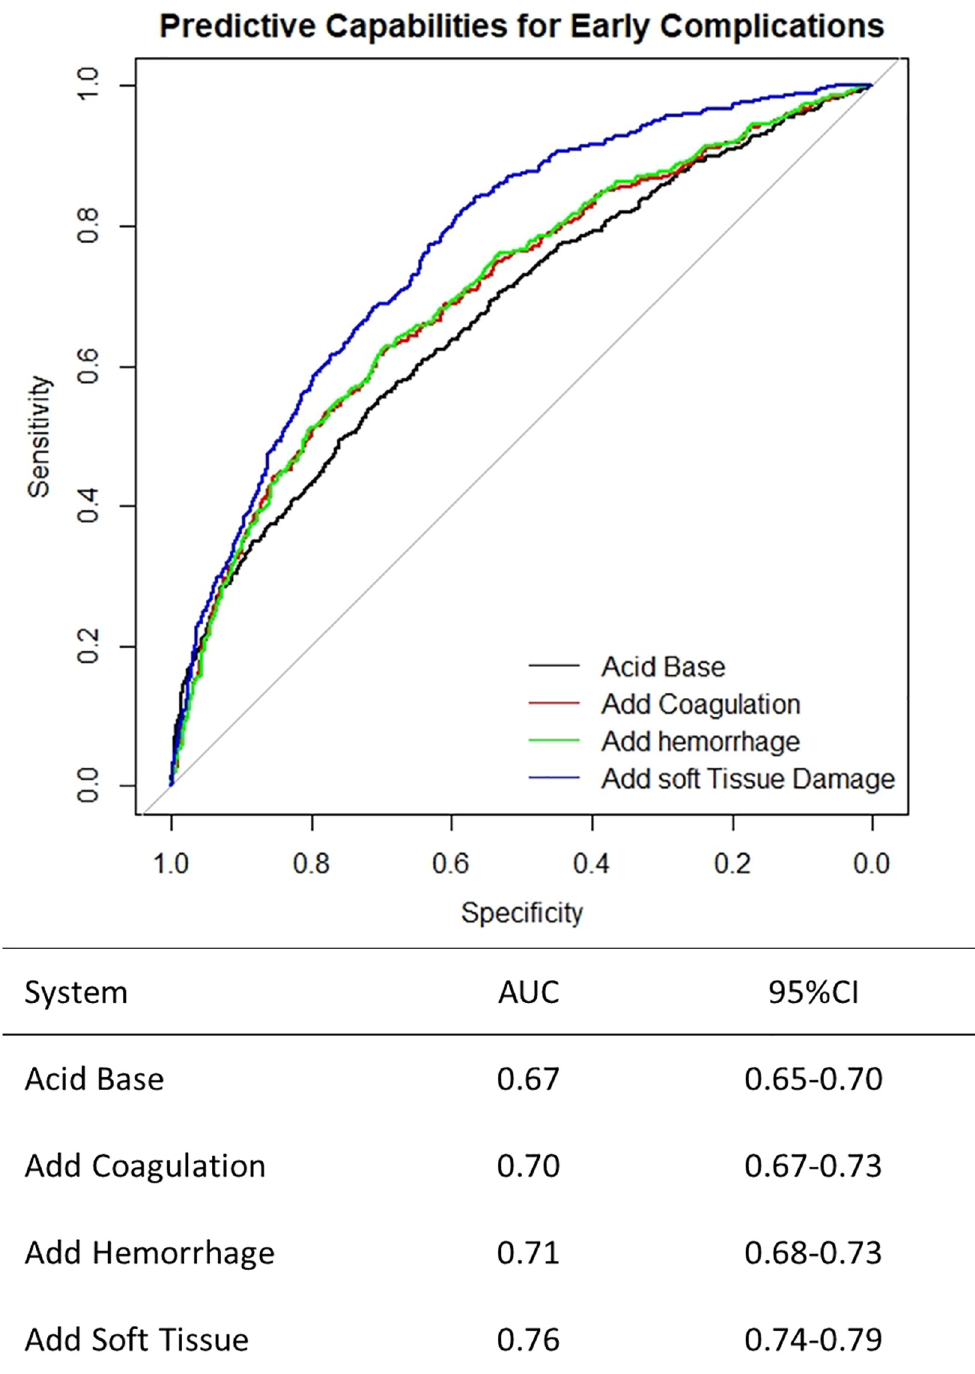
Fig 1. Comparison of the ability to predict early complications of acid base changes alone (black), addition of coagulopathy (red), addition of acute hemorrhage (green), and addition of soft tissue injuries (blue). The addition of these parameters lead to a sustained improvement in prediction of complications. Early Complications include Death within 72 hours, Death from traumatic brain injury, Death from exsanguination. AUC = Area Under the Curve. 95% CI = 95% Confidence